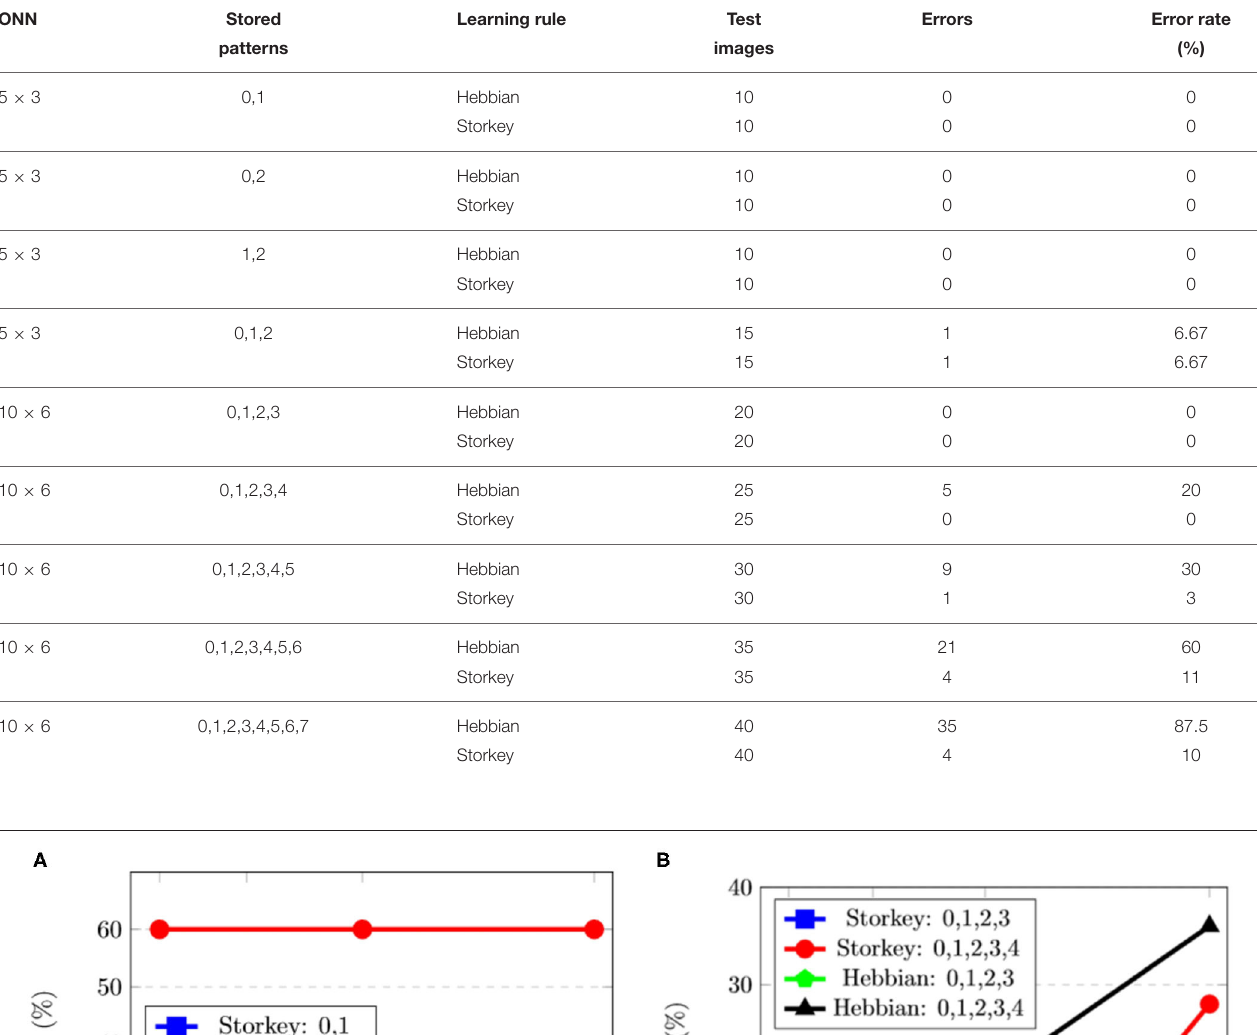
TABLE 4 | Experimental error rate of the 5 × 3 and the 10 × 6 ONN implemented on FPGA for various training configurations. ONN Stored Learning rule Test Errors Error rate images